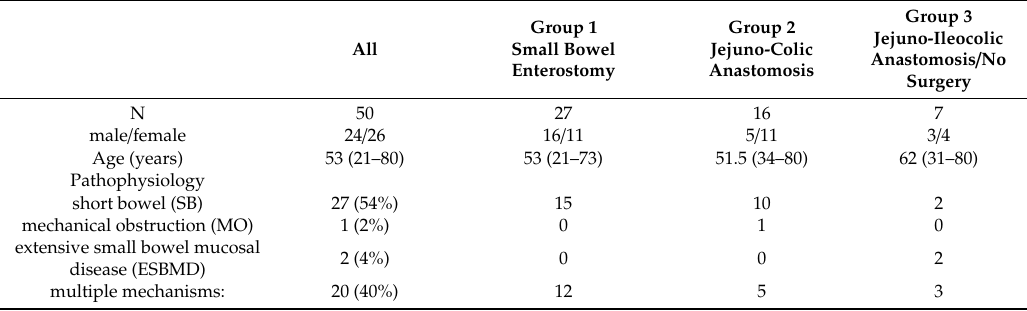
Table 1. Demographics of the study population and of the groups defined by their functional anatomy. Median